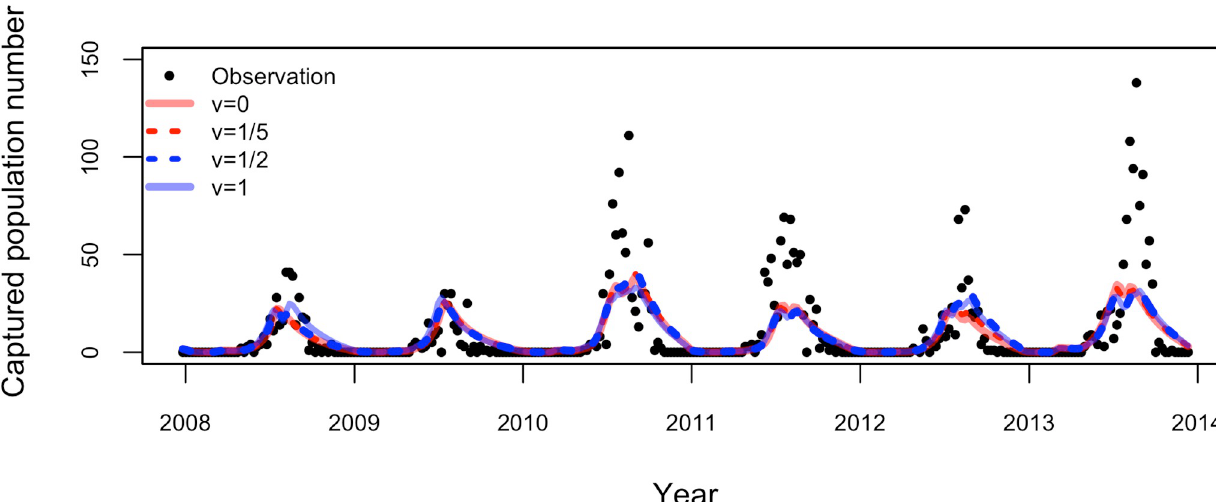
Fig 2. Population dynamics during calibration (2003–2010) and validation (2011–2013) periods. The black circle represents the observation data, and lines represent the predicted population dynamics using different models,